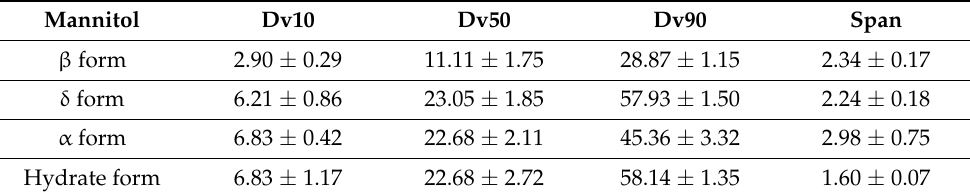
Table 1. Particle size distribution expressed as equivalent volume diameters (Dv, µ m) and span ± standard